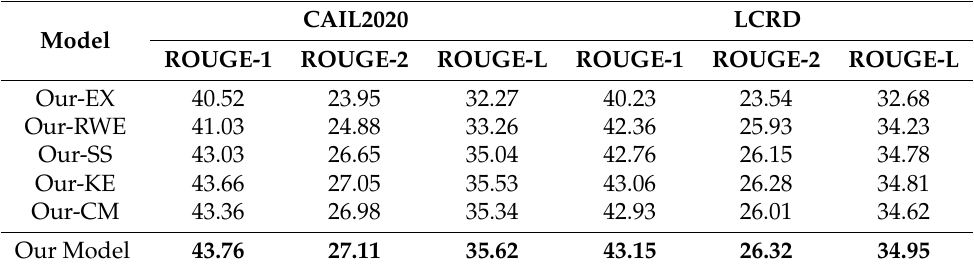
Table 2. Results of ablation experiments on two datasets. We removed specific modules from the framework separately and compared the